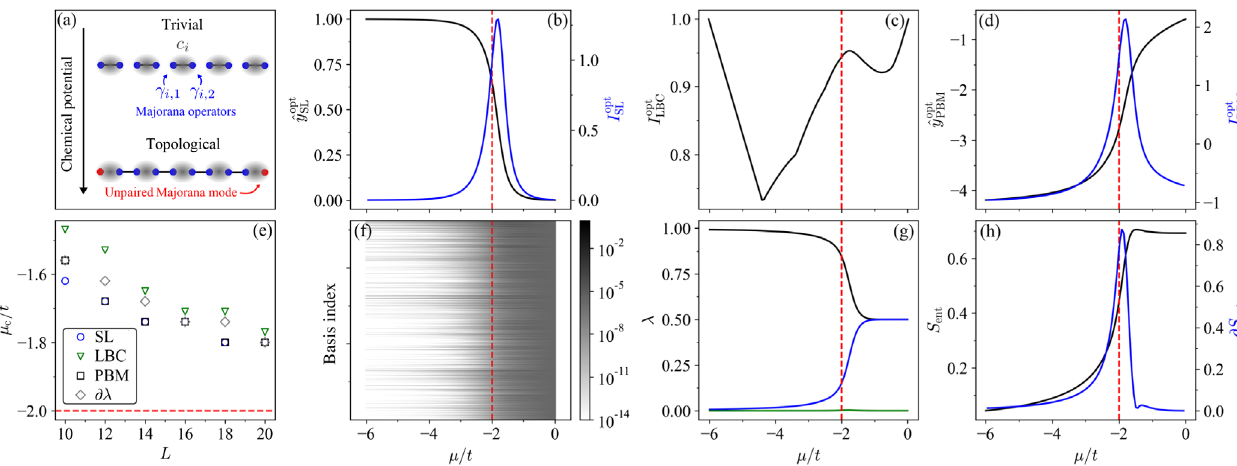
FIG. 7. Results for the Kitaev chain ( L ¼ 20 ) with the dimensionless chemical potential as a tuning parameter p ¼ μ =t , where 0 , and Δ p ¼ 0 . 06 . In SL, the data obtained at p 1 and l p 1 ¼ − 6 , p K . The critical 1 and p K constitute our training set, i.e., r I ¼ K ¼ II ¼ =t ¼ − 2 is highlighted by a red dashed line. (a) Illustration of the phase transition in the Kitaev chain between a topological and value μ ffiffiffi ffiffiffi c p p γ 2 2 i γ = trivial phase, where the Majorana operators γ and γ are defined by c , c † . (b) Mean optimal ¼ ð γ i; 1 − i γ i; 2 Þ = i; 1 i; 2 i ¼ ð i; 1 þ i; 2 Þ i prediction ˆ y opt in SL (black line) and the corresponding indicator I opt (blue line). (c) Optimal indicator of LBC, I opt (black line). SL SL LBC in PBM (black line) and the corresponding indicator I opt (blue line). (e) Estimated critical value of (d) Mean optimal prediction ˆ y opt PBM PBM the tuning parameter based on I opt (SL), I opt (LBC), I opt (PBM), and the derivative of the largest eigenvalue of the reduced density PBM SL LBC matrix [see the black line in (g)] given by ∂ λ = ∂ p ( ∂ λ ), as a function of the chain length L . The estimated critical value of the tuning parameter denoted by ∂ λ corresponds to the location of the minimum in ∂ λ = ∂ p . (f) Probability distributions governing the input data (indices of Fock basis states) as a function of the tuning parameter, where the color scale denotes the probability. The color scale is cut off at 10 − 14 to improve visual clarity. (g) The three largest eigenvalues of ρ [Eq. (38)] as a function of the tuning parameter. A = ∂ p (blue (h) Entanglement entropy S [Eq. (39)] (black line) and its derivative with respect to the tuning parameter ∂ S ent ent